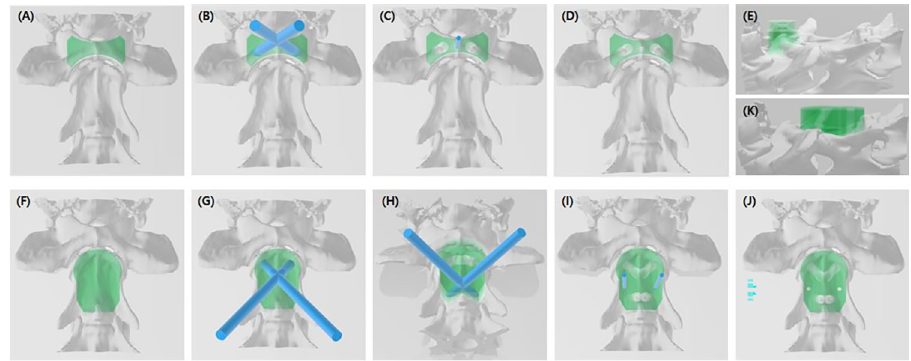
Fig 1. The manufacturing process of the patient-specific guide based on the bone model. Drill guide template for C1 (A) and C2 (F) before making holes. Each hole with a diameter similar to the drill sleeve (B, G and H). A temporary pinhole in the center of the C1 guide, and (C) two temporary pin holes on both sides of the C2 body (I). Completed design of the C1 (D and E) and C2 (J and K) patient-specific drill guide.